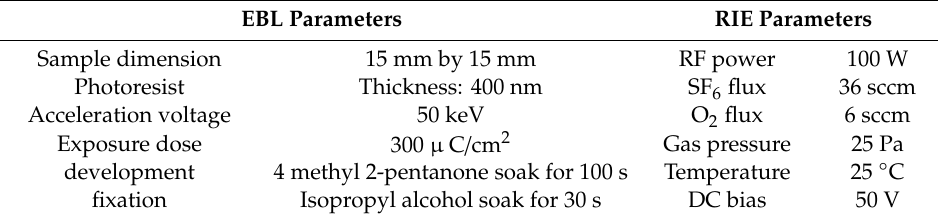
Figure 2. Schematic diagram of waveguide manufacturing process. Table 1. Electron beam lithography and reactive ion etching process parameters.